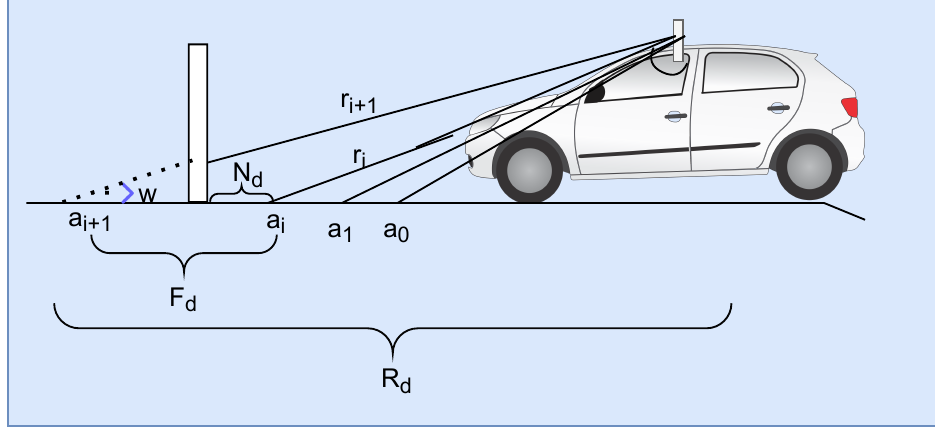
Figure 2. Parameters involved in the process of extraction and removal of floor points, where F d is the anticipated range dissimilarity and N d is the actual range dissimilarity among two 3D